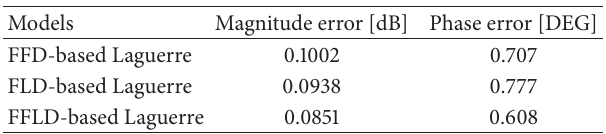
Table 3: Standard deviations of frequency responses for the ana- lyzed models; Example